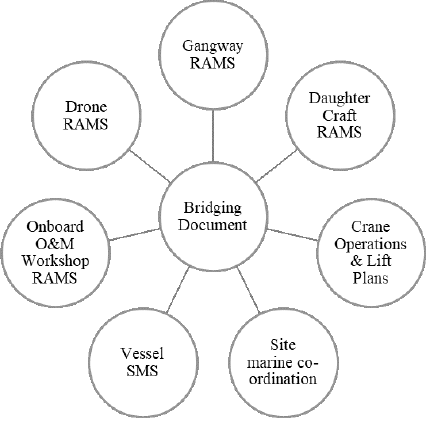
Figure 1. Illustration of current safety